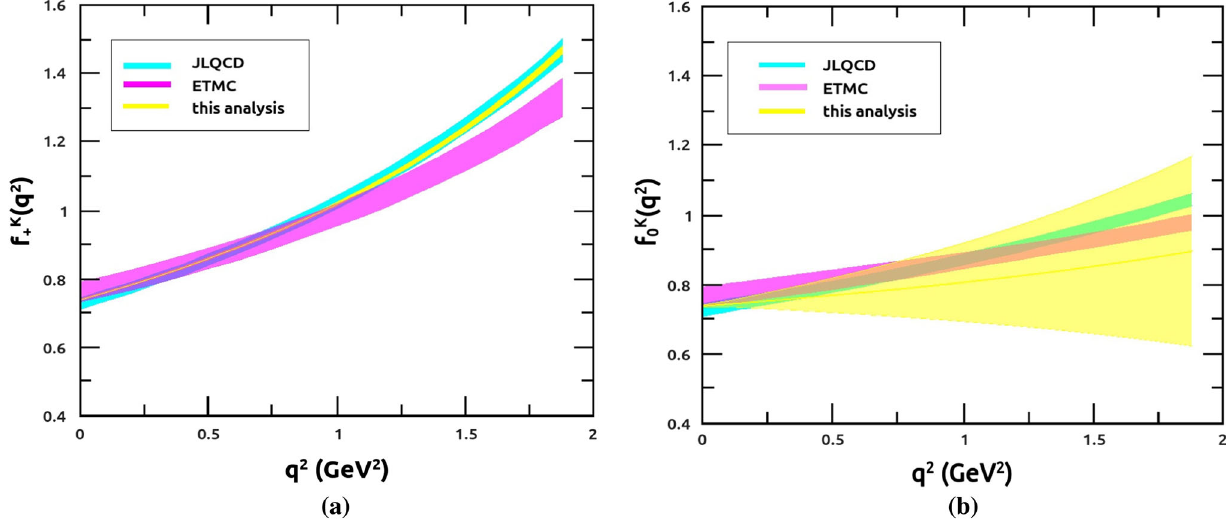
( q 2 ) (b). The yellow bands are the results of this work. The cyan and pink bands are from the Fig. 4 The shapes of f K + ( q 2 ) (a) and f K 0